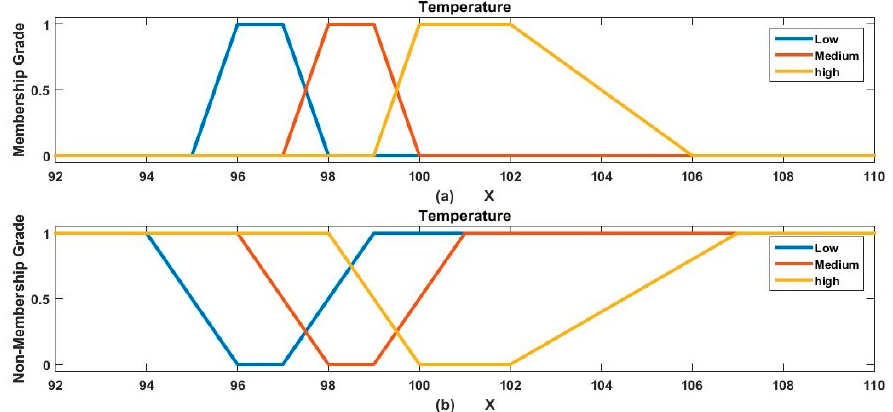
Figure 2. Three linguistic categories of temperature with their trapezoidal membership ( a ) and non-membership grades ( b ).